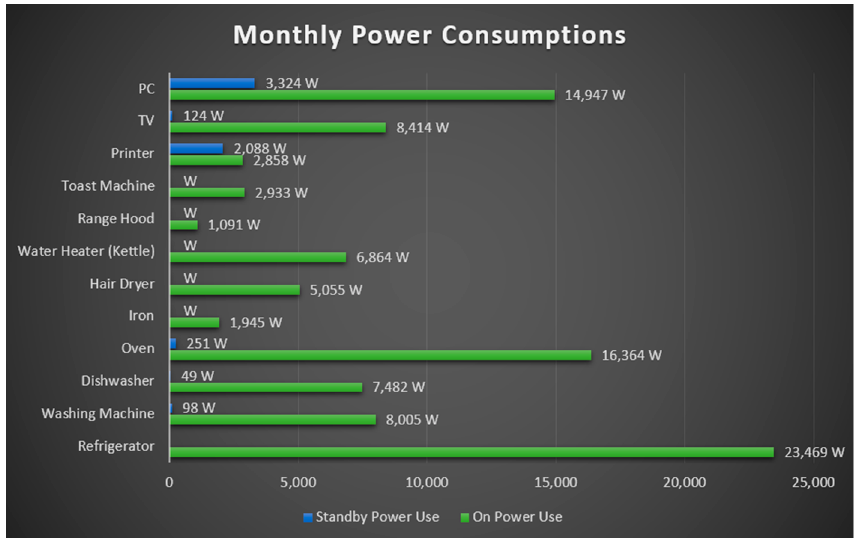
Figure 20. The total and standby power consumption of the household appliances for November.